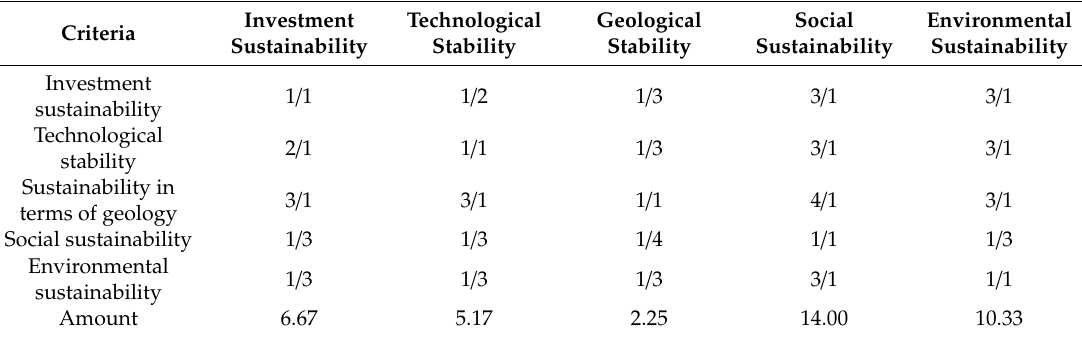
Table 4. Evaluation of Level 1 criteria.